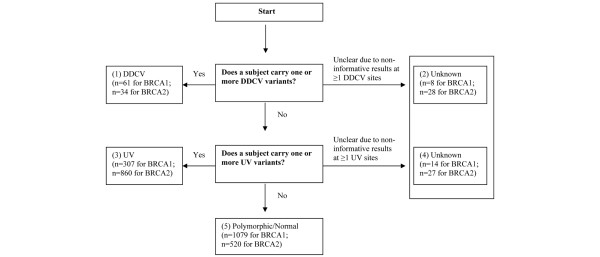
Illustration of the classification scheme of BRCA1/BRCA2 variants. DDCV, definitely disease-causing variant; UV, unclassified variant.